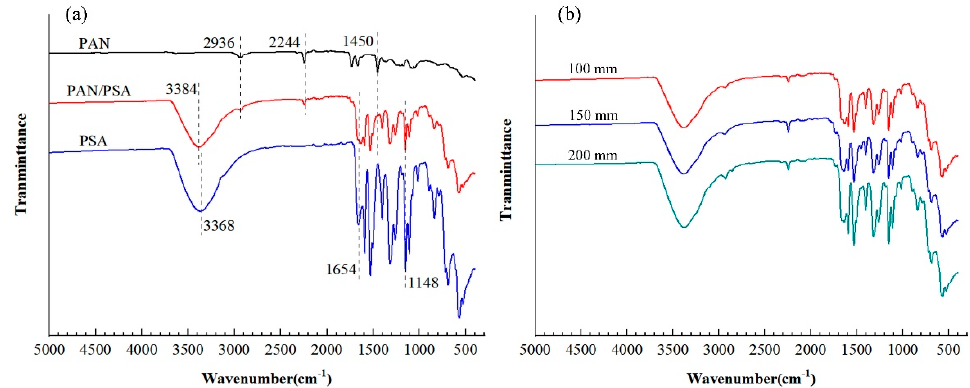
Figure 9. FTIR of different membranes: ( a ) prepared with different materials; ( b ) prepared at different receiving distances.